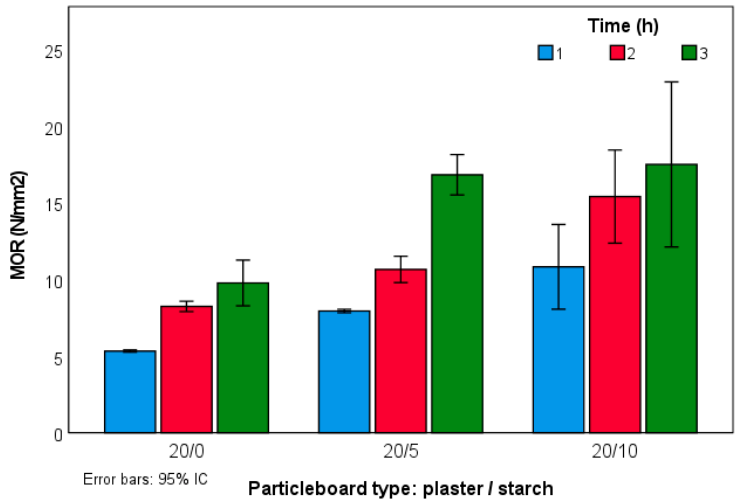
Figure 5. MOR values of the experimental panels.